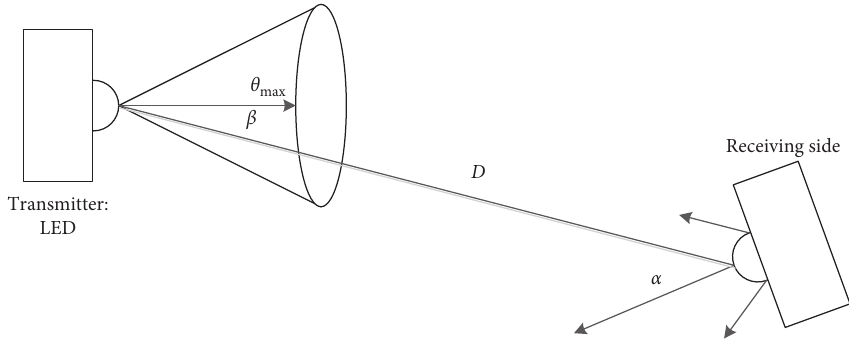
Figure 7: Visible light communication scene in fire smoke environment.